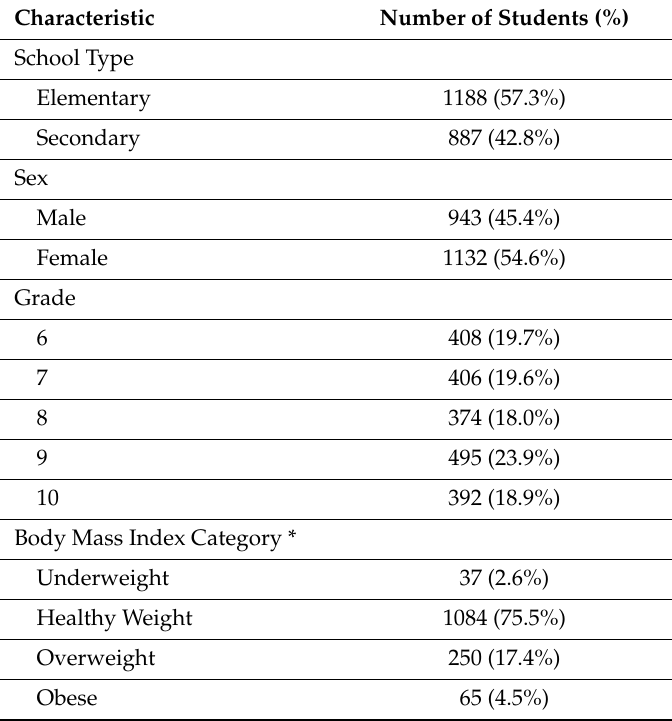
Table 1. Demographic characteristics of students included in the evaluation of Ontario’s School Food and Beverage Policy ( n = 2075